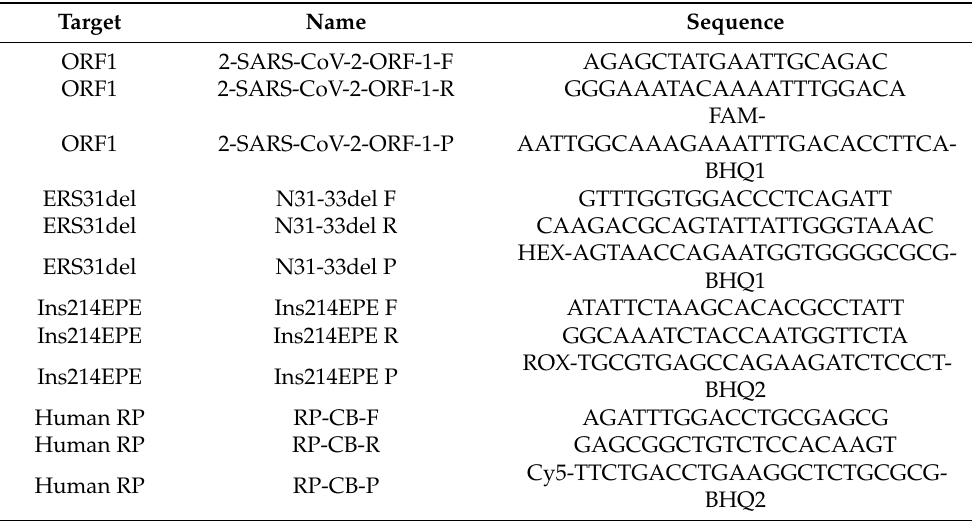
Table 5. Primer and probe sequences for the multiplex RT-qPCR assay for the Omicron lineage detection with BA.1